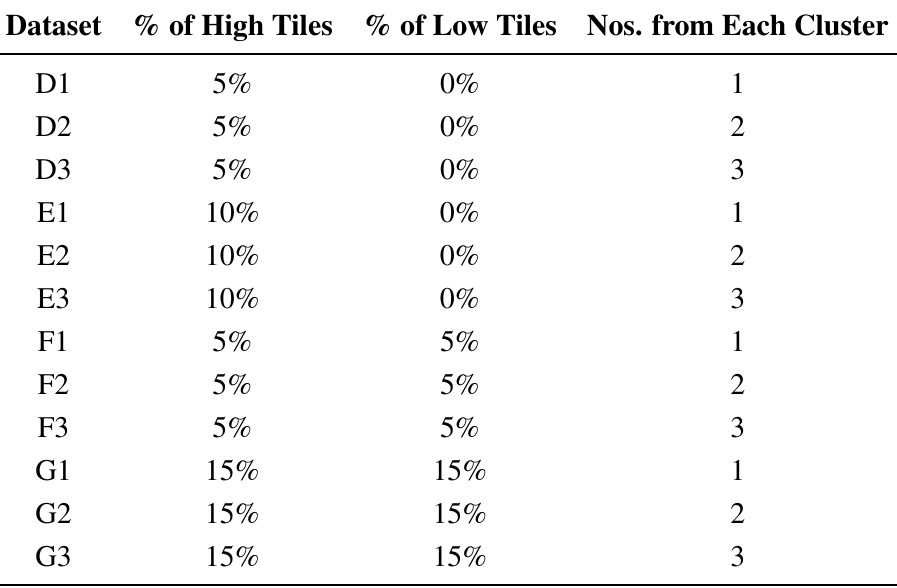
Table 6. The D, E, F and G series datasets combine tiles with high and low amounts of change in them with prototypical cluster members to form diverse training datasets.